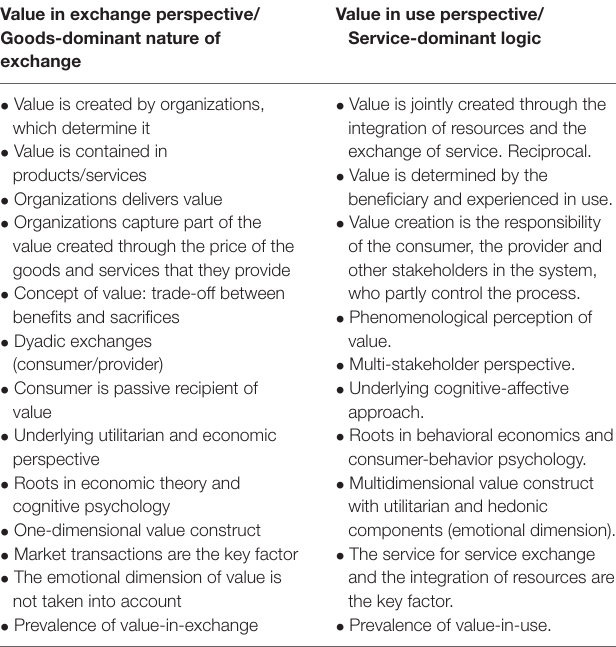
TABLE 1 | From a perspective of value-in-exchange to one of value-in-use. Value in exchange perspective/ Goods-dominant nature of